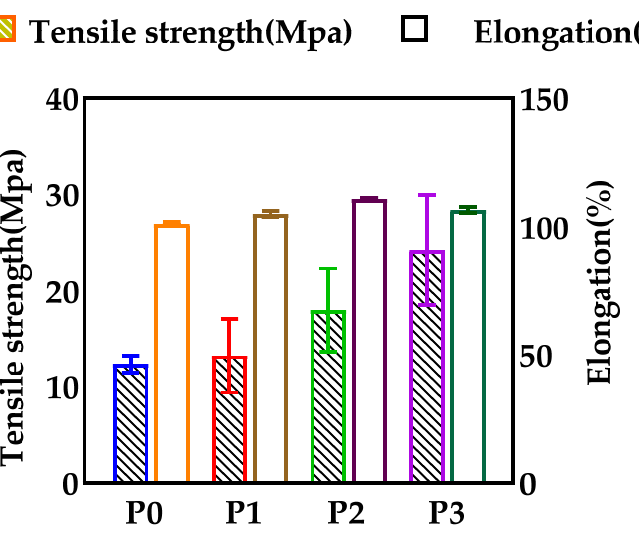
Figure 17. Tensile strength and elongation at break of different GO doped membranes.